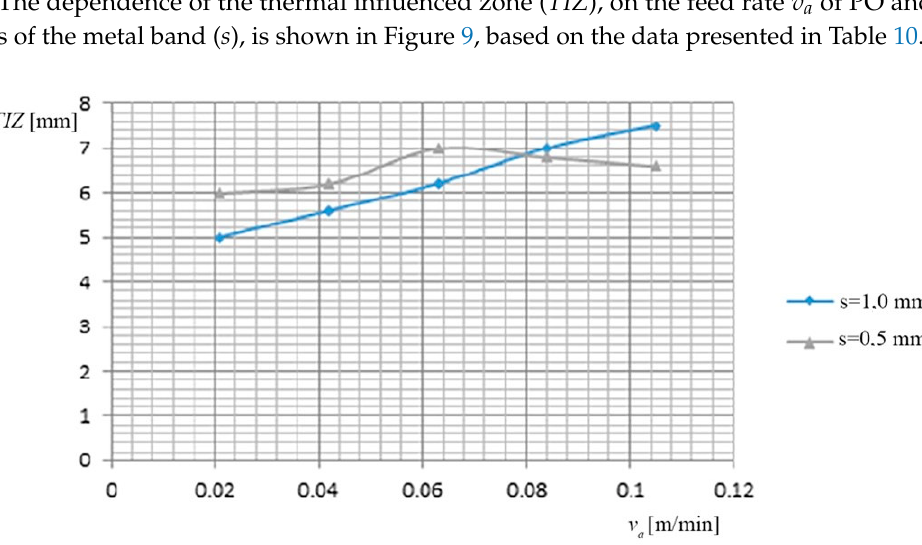
Figure 9. Dependence TIZ on the feed rate v a of PO and on the thickness of the metal band ( s ).